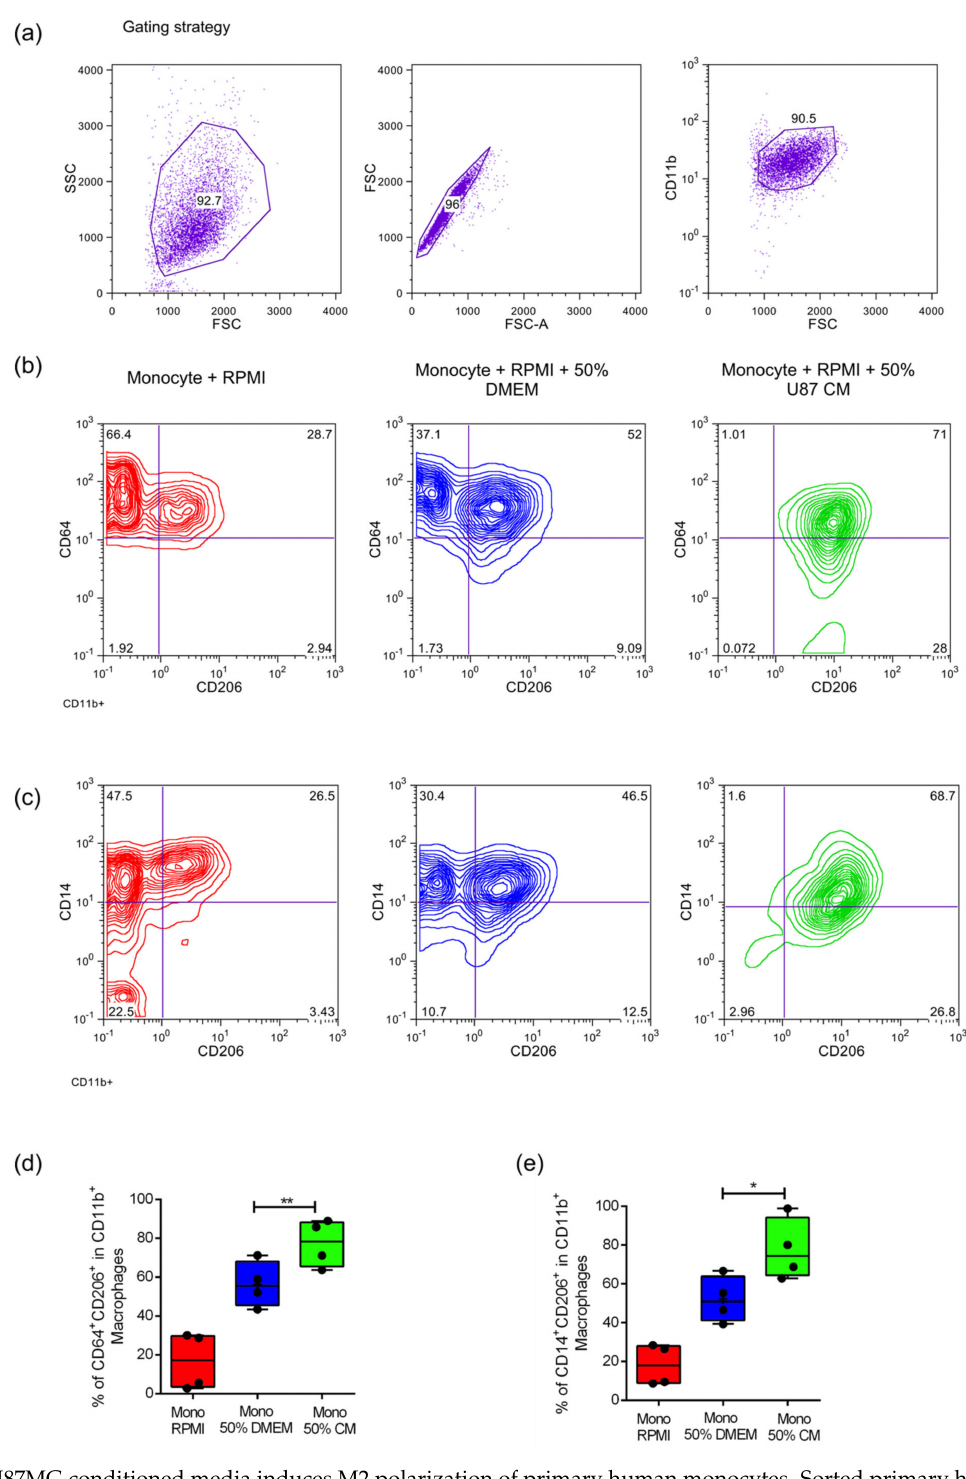
Figure 1. U87MG conditioned media induces M2 polarization of primary human monocytes. Sorted primary human CD14 + monocytes (Mo) were incubated for 5–7 days in complete RPMI (RPMI), complete RPMI + 50% complete DMEM low glucose (50% DMEM) and complete RPMI + 50% U87MG conditioned media (CM) (50% CM) to obtain monocyte-derived macrophages as explained in materials and methods. ( a ) Gating strategy to discriminate CD11b + macrophages at day 7. ( b , c ) Representative contour plots showing the percentage of CD64 + CD206 + and CD14 + CD206 + in CD11b + cells after 7 days of incubation with RPMI, 50% DMEM and 50% CM. ( d , e ) Independent data showing the increased percentage of CD64 + CD206 + and CD14 + CD206 + respectively, of CD11b macrophages under CM treatment ( n = 4). In both cases two tailed paired t -tests were performed *: p ≤ 0.05; **: p ≤